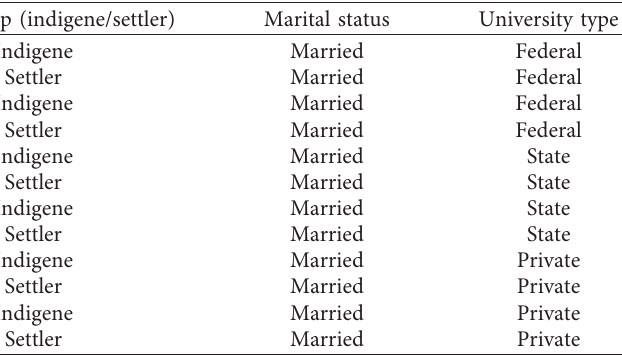
Table 1: Participants sociodemographic background.